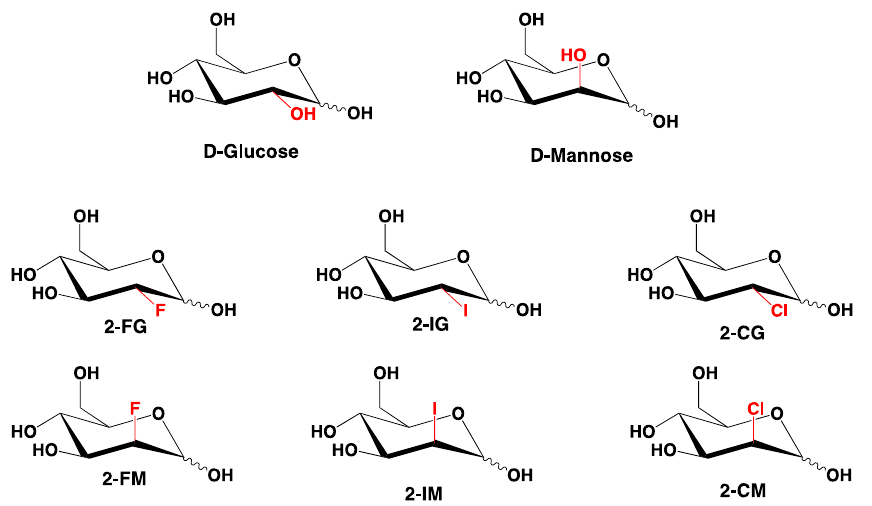
Figure 1. Chemical structures of investigated compounds. These compounds can be considered as 2-substituted D-glucose (Glc) or D-mannose (Man) derivatives. 2-substituted D-glucose (Glc) or D-mannose (Man)